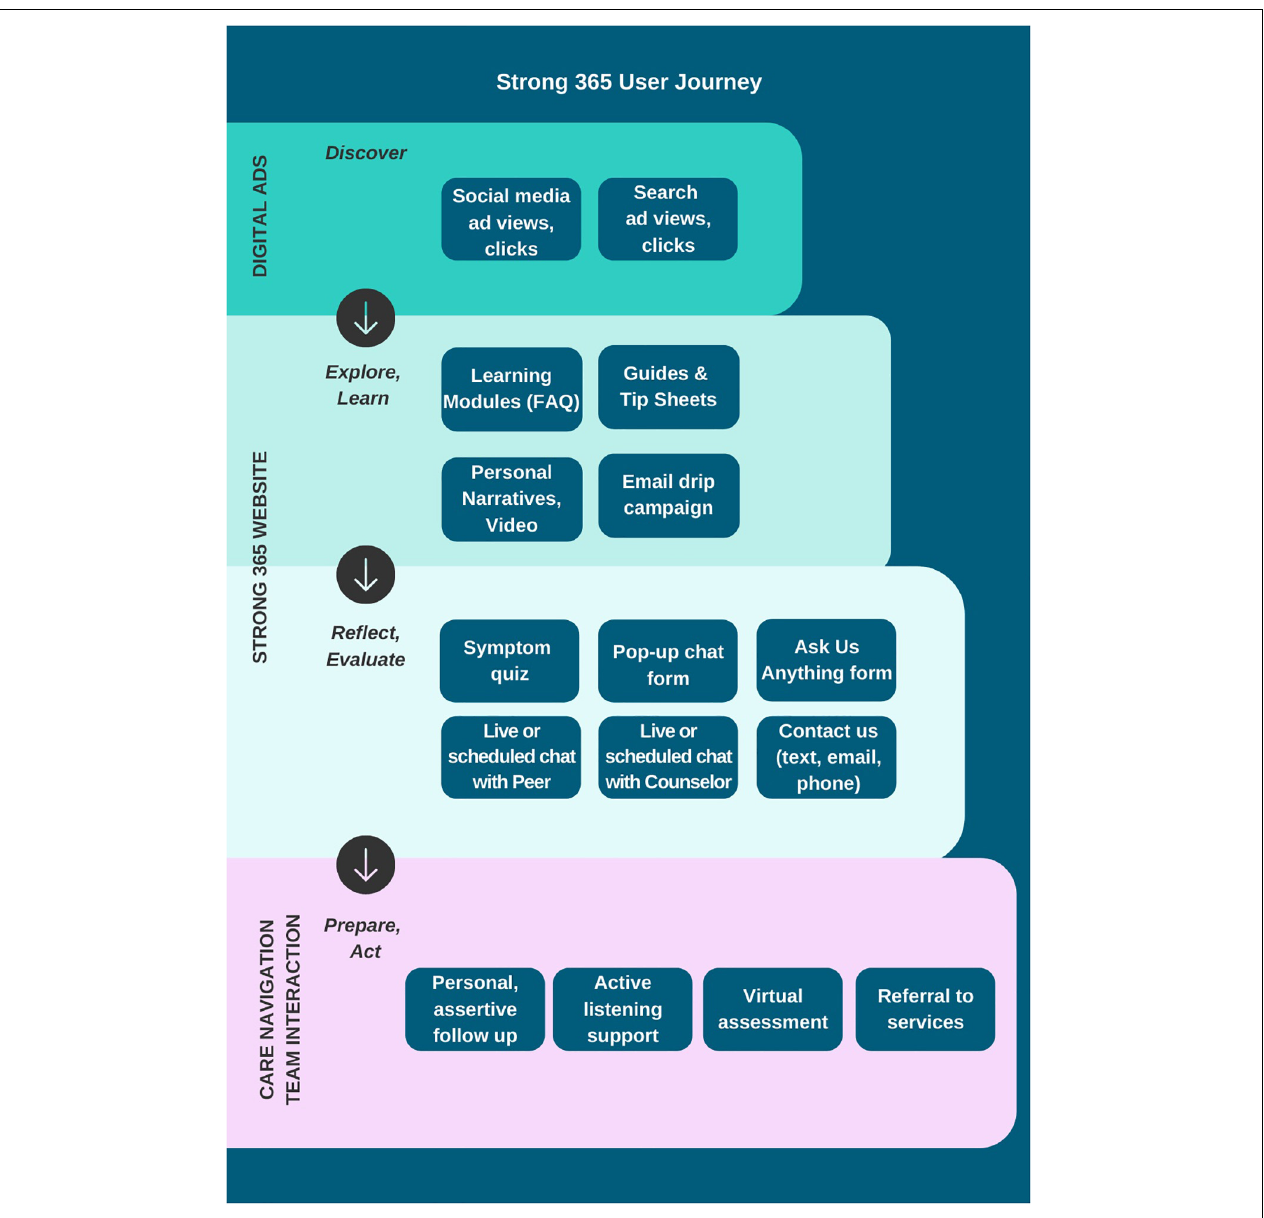
FIGURE 1 | User experience from ad to